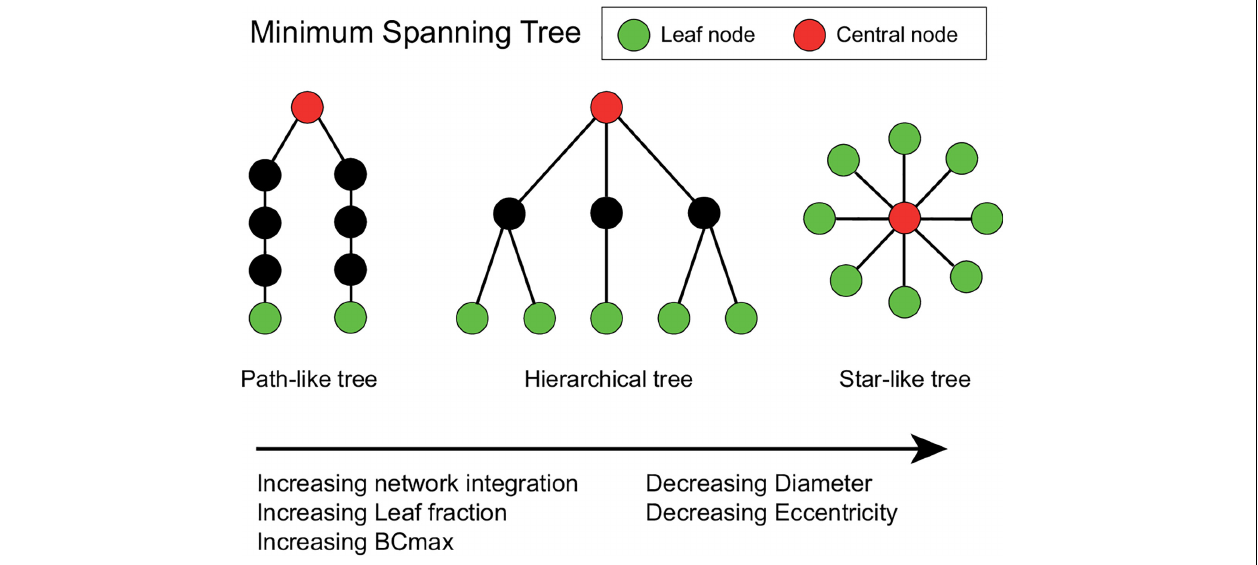
FIGURE 2 | Schematic representation of three minimum spanning trees (MSTs). MST structures can range from a path-like tree (i.e., minimally integrated network) to a star-like tree (i.e., maximally integrated network). Green nodes represent leaf nodes (i.e., end-nodes in the graph), while red nodes represent central nodes. The hierarchical tree combines the relatively small diameter with the relatively low betweenness centrality (BCmax) value, which prevents information overload on the central node making this an optimal configuration (Stam and van Straaten, 2012). The Figure was adjusted from van Dellen et al. (2014) and van Lutterveld et al. (2017).